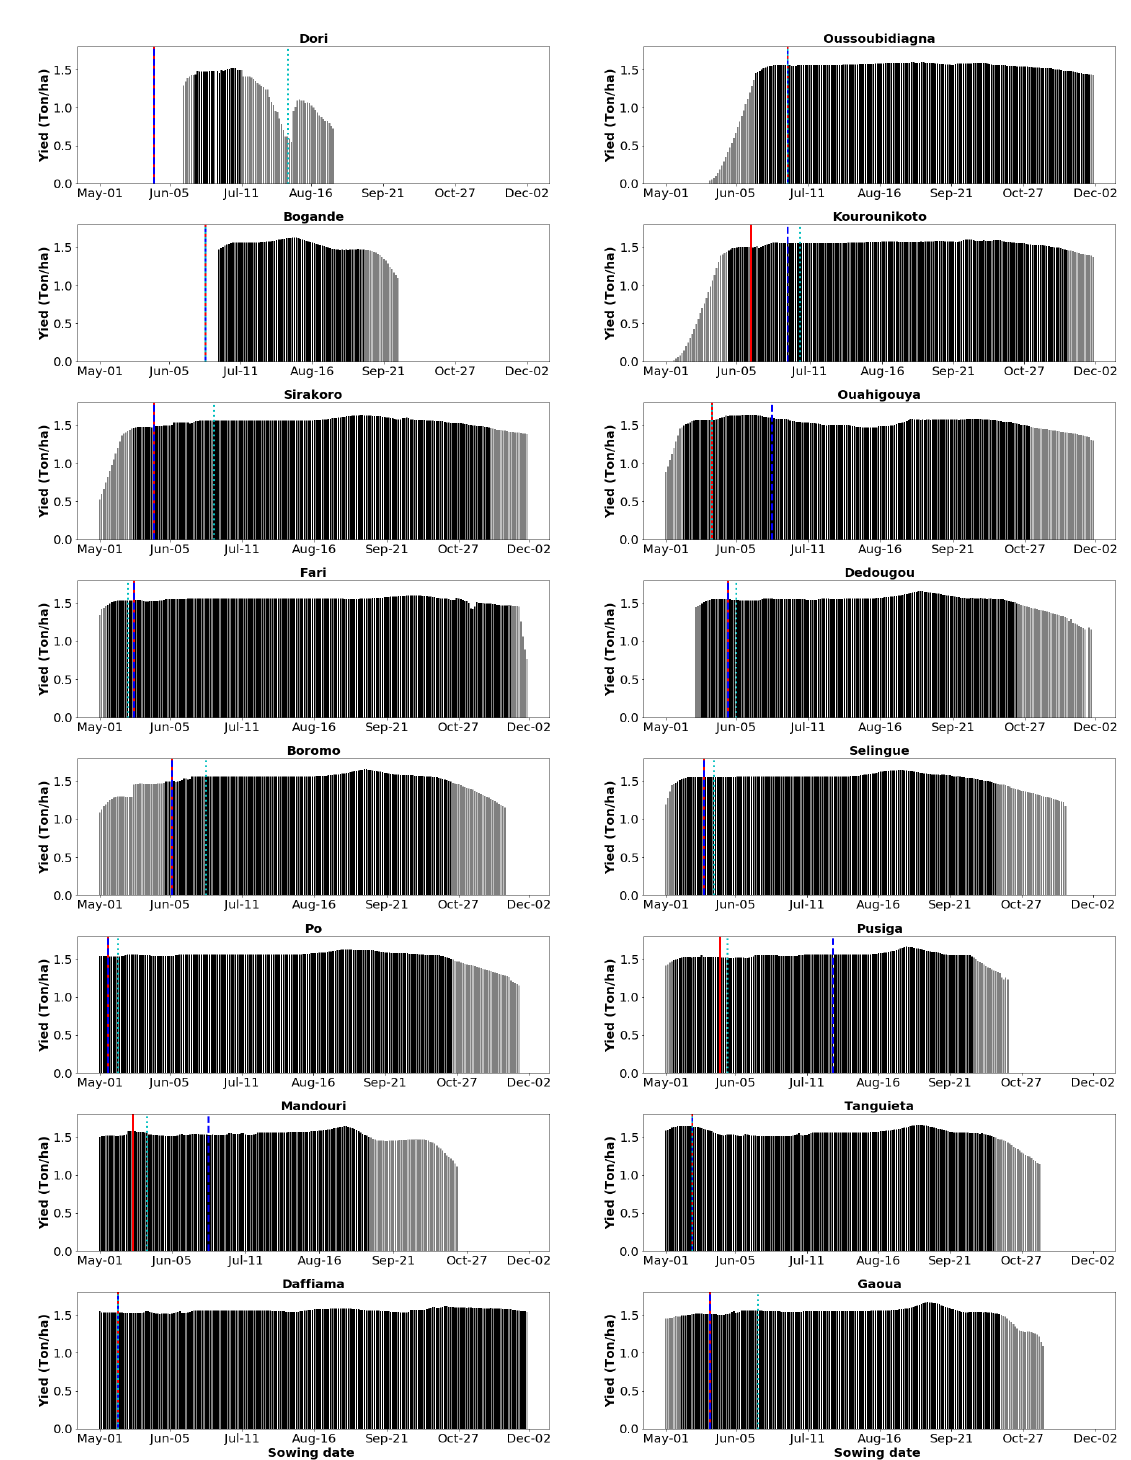
Figure A1. Variation of yield response to each date of the sowing window from 1st May to 31st November in 2018 expressed as bar chart for the available locations. The dark bars represent the safe windows and the vertical lines represent the different sowing based on the three definitions: (i) red for FP20mm, (ii) blue for LO20mm, and (iii) cyan for